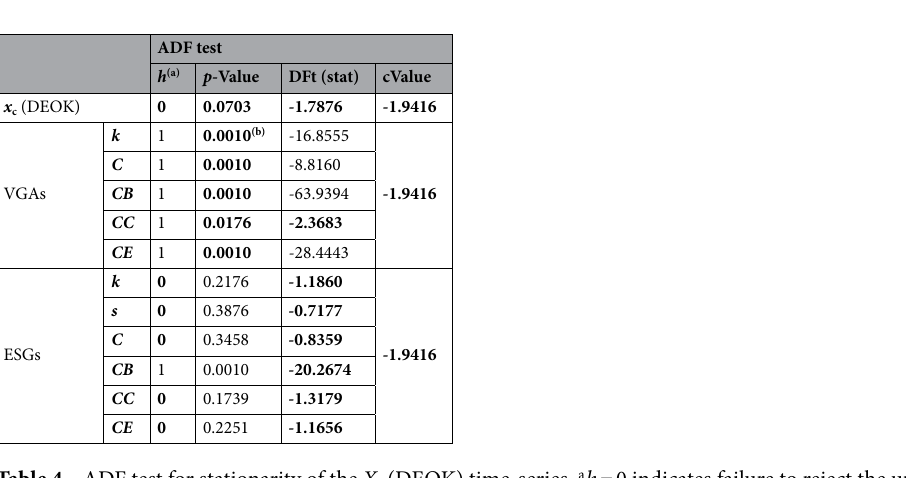
Table 4. ADF test for stationarity of the X c (DEOK) time-series. a h = 0 indicates failure to reject the unit-root null (indication: non-stationary series). h = 1 indicates rejection of the unit-root null in favor of the alternative model (indication: stationary series). b. Cases shown in bold are the closest between concordant measures to the source time-series